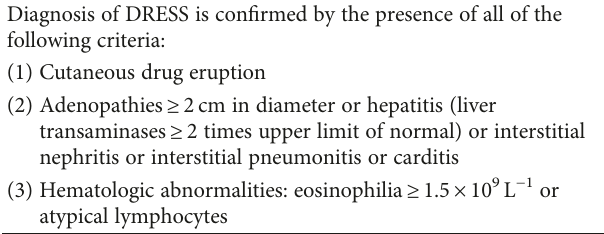
systemic symptoms (DRESS)